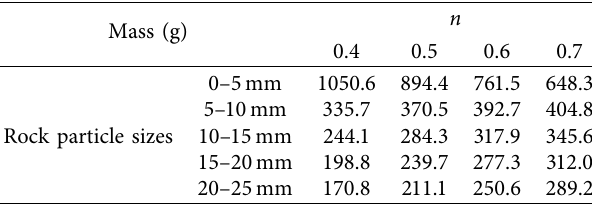
Table 1: The mass qualities of different diameters broken rock with different Talbot power exponents.